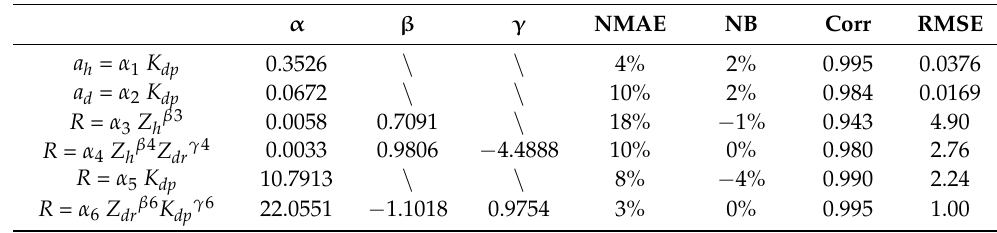
Table 7. As for Table 5, but for stratiform